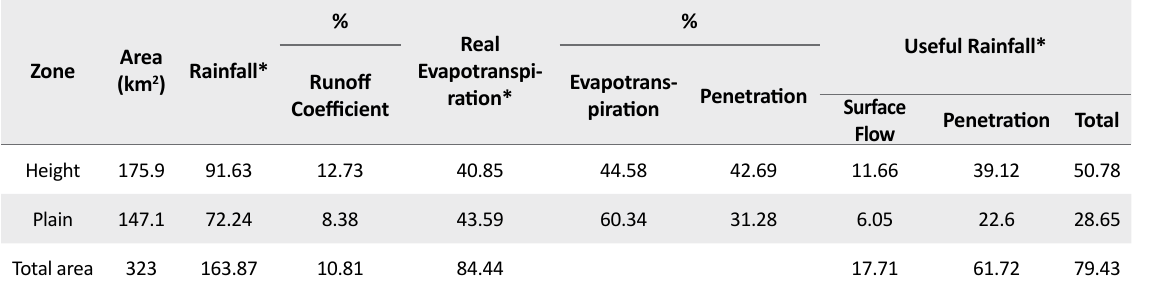
Table 1. Hydro-climatologic balance of heights and plains in Quar Maharlu [29]